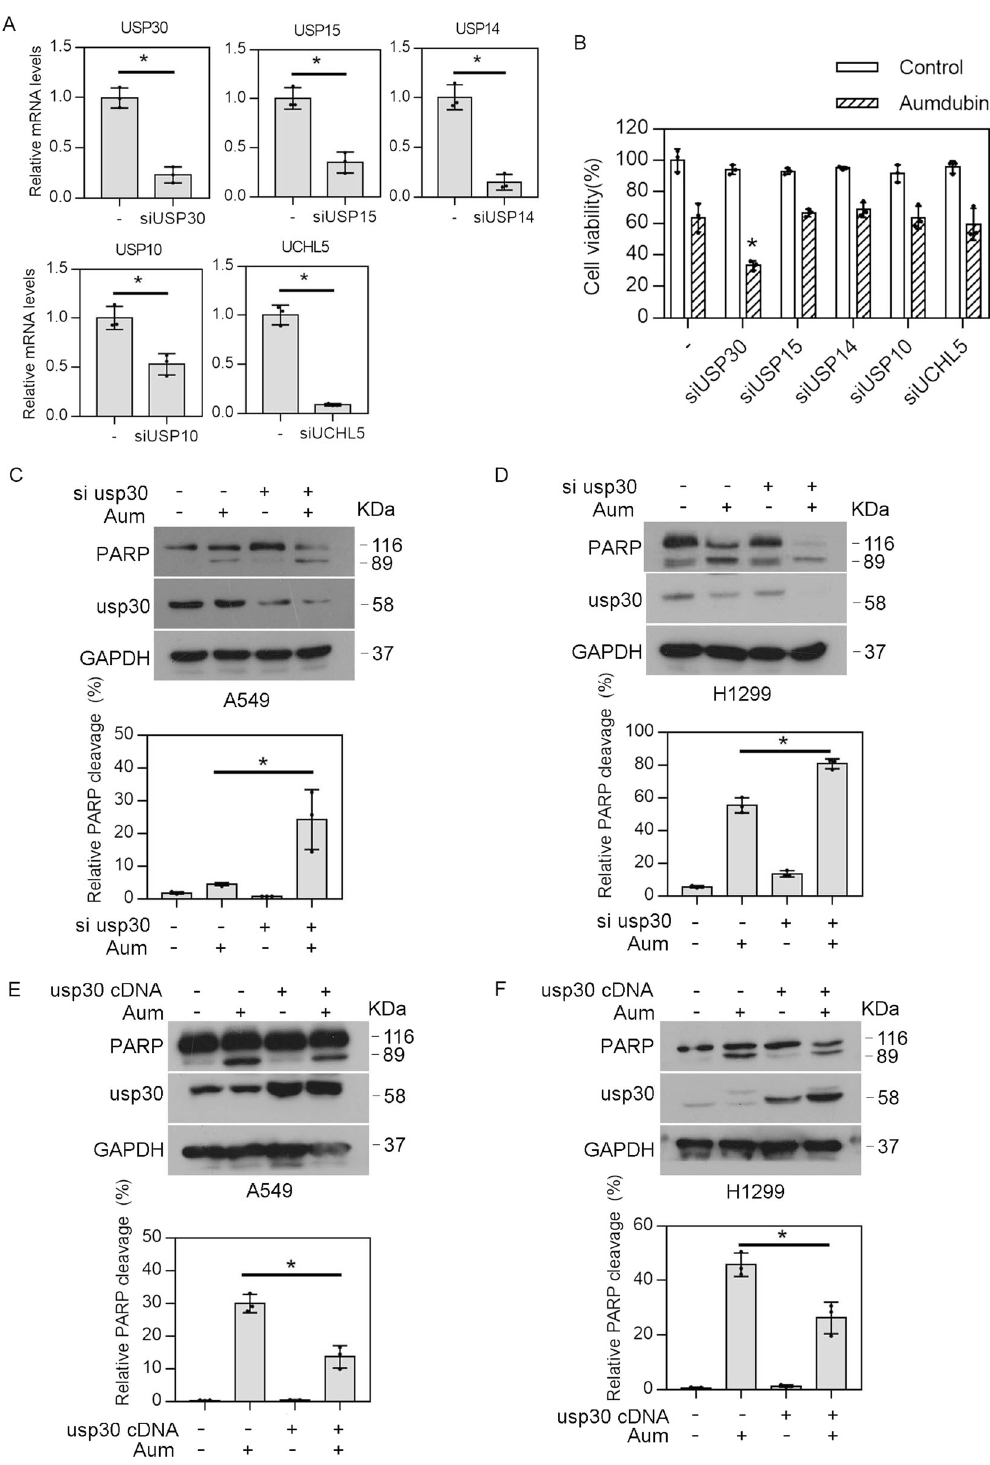
Fig. 5 USP30 inhibition sensitizes cancer cells to aumdubin in lung cancer cells. A H1299 cells were transfected with Control siRNA or the indicated DUBs siRNA for 48 h, then mRNA expression of the indicated DUBs was measured by RT-qPCR and its expression level relative to the control was calculated. Mean ± SD ( n = 3), * P < 0.05, versus control. B Knockdown of USP30 enhances aumdubin-induced cell death. H1299 cells were transfected with Control siRNA or the indicated DUBs siRNA for 24 h, followed by treatment with or without 1 μ M aumdubin (Aum) for 24 h. The cell viability was measured by using MTS assay. Mean ± SD ( n = 3), * P < 0.05, versus aumdubin alone. C , D Knockdown of USP30 enhances aumdubin-induced apoptosis. A549 ( C ) or H1299 ( D ) cells were transfected with Control siRNA or USP30 siRNA for 24 h, followed by treatment with or without 1 μ M aumdubin (Aum) for 24 h. E , F Overexpression of USP30 attenuates aumdubin-induced apoptosis. A549 ( E ) or H1299 ( F ) cells were transfected with vector or usp30 cDNA plasmids for 24 h, followed by treatment with or without 1 μ M aumdubin for 24 h. PARP and USP30 were analyzed with western blotting. The relative quanti fi cation of cleavage PARP/total PRAP were shown. GAPDH was used as a loading control. Cell Death Discovery (2021)